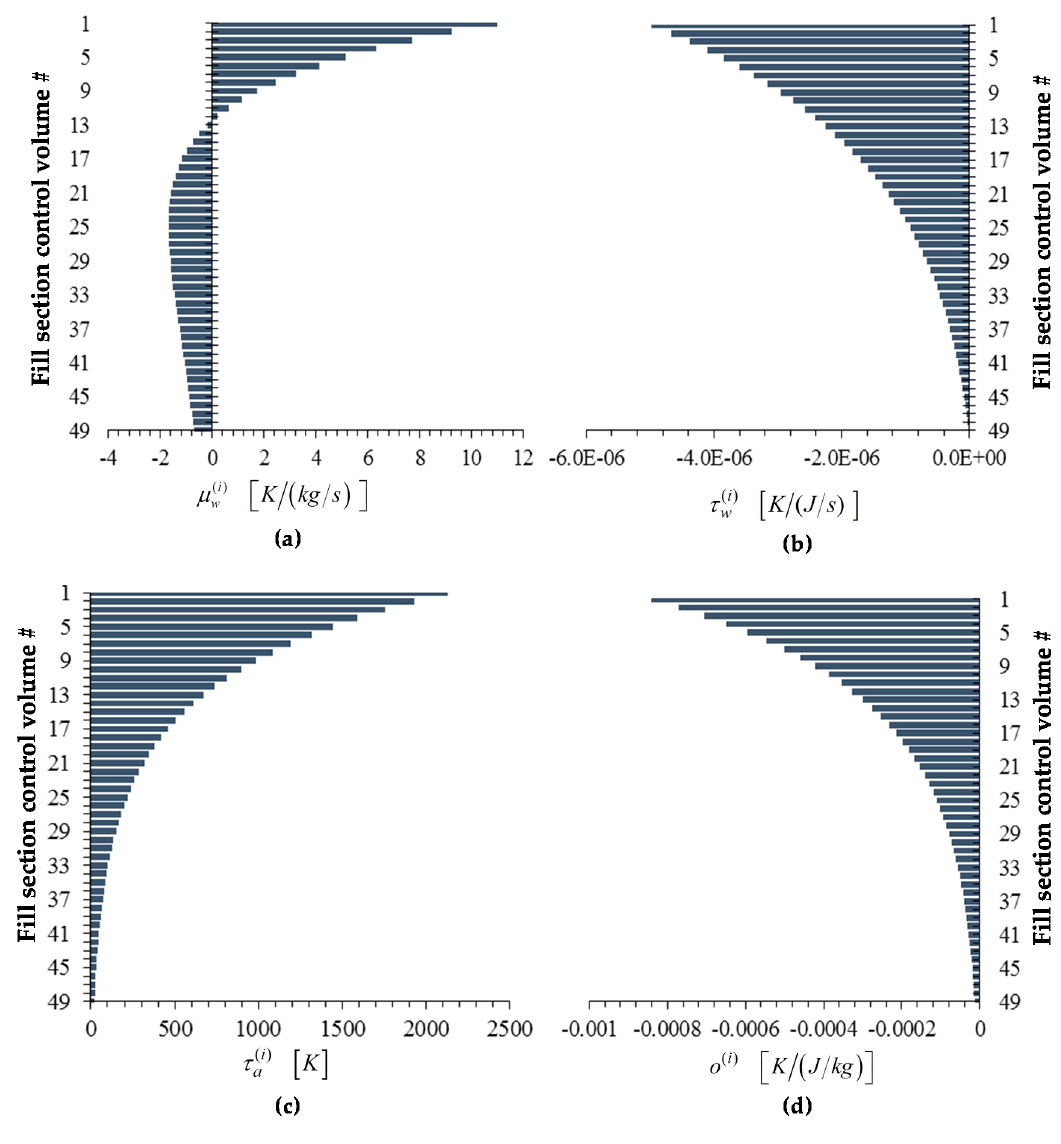
( 1 ) R T as functions of the height of the a as functions of the height of the a (cid:16) (cid:17) (cid:16) (cid:17) (cid:16) (cid:17) ( 1 ) ( 49 ) ( 1 ) ( 49 ) ( 1 ) ( 49 ) µ τ τ ; ( b ) τ w (cid:44) ; ( c ) τ a (cid:44) w ,..., µ w w ,..., τ w a ,..., τ a